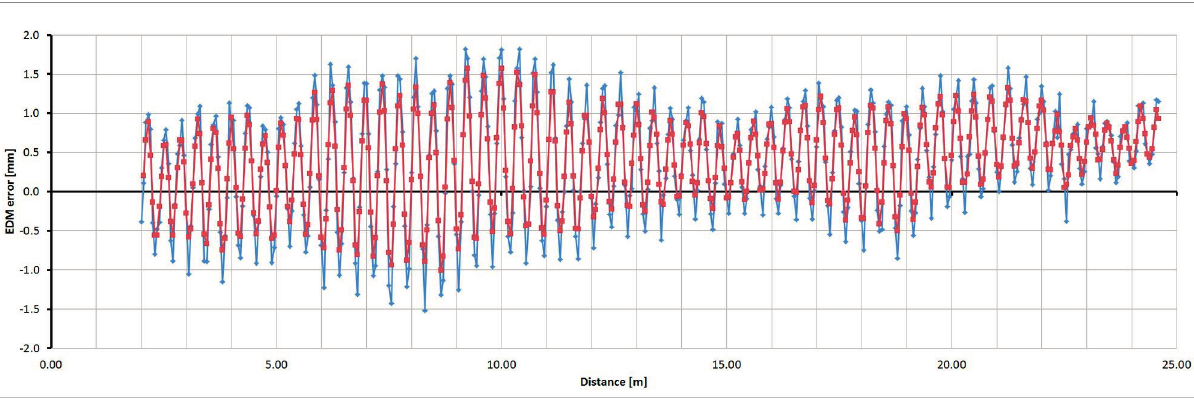
Figure 28. Relative errors of the Trimble S6 instrument (measured blue, averaged red).